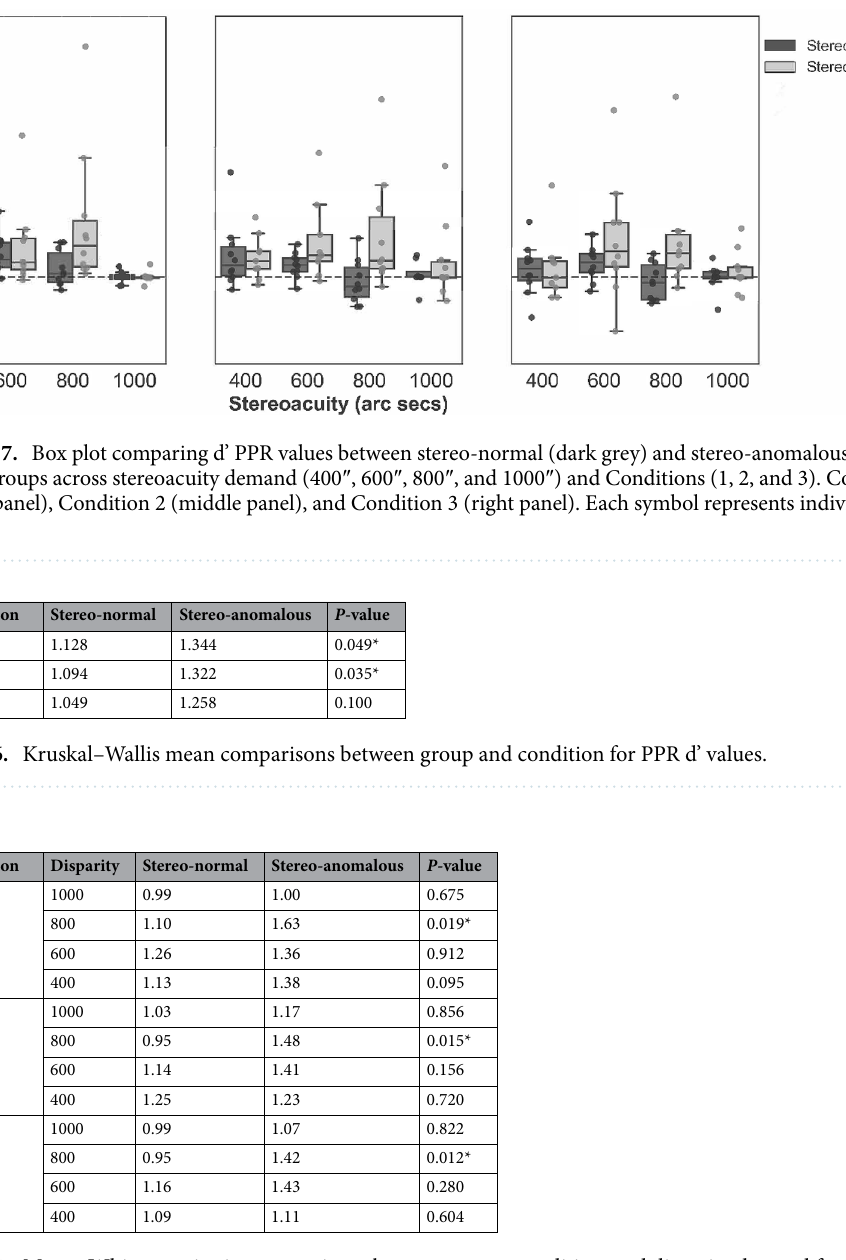
Table 7. Mann–Whitney pairwise comparisons between group, condition, and disparity demand for PPR d’ values.